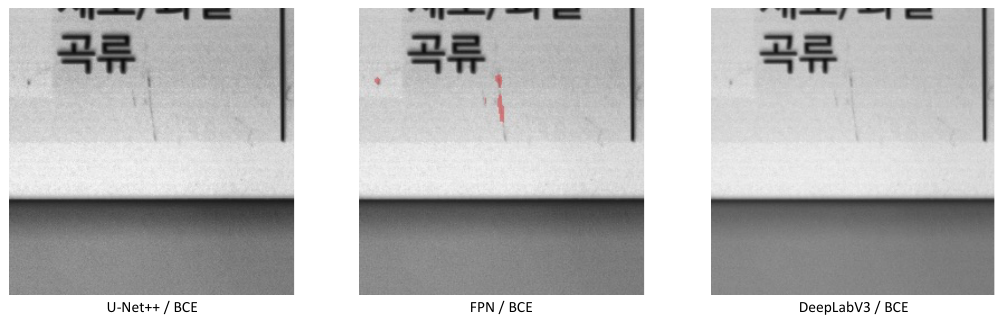
Figure 19. Images detected using patch-split method and a single loss function.